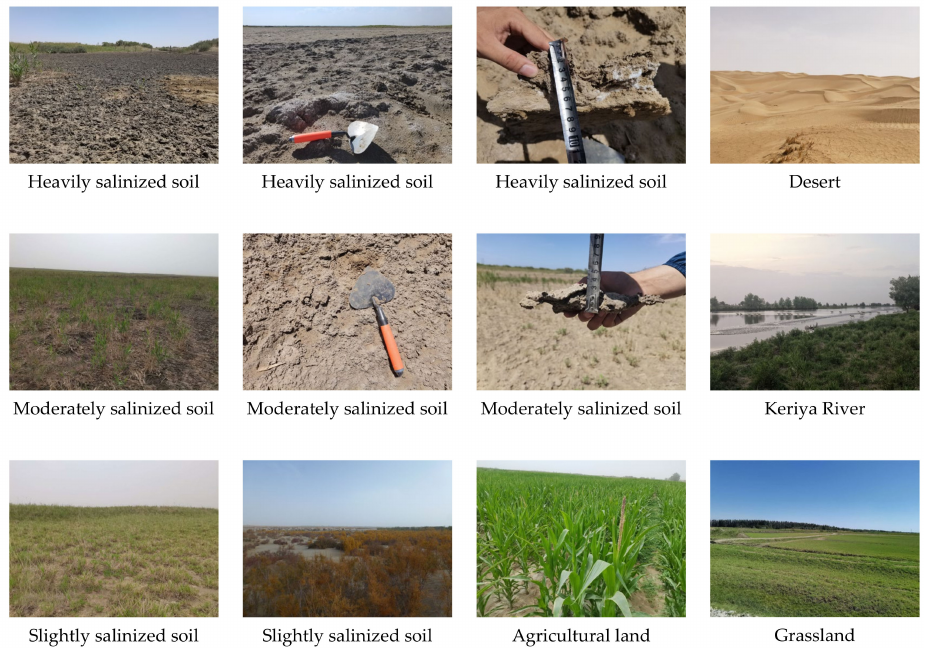
Figure 3. Different degrees of salinized soil types of Keriya Oasis in the study area.